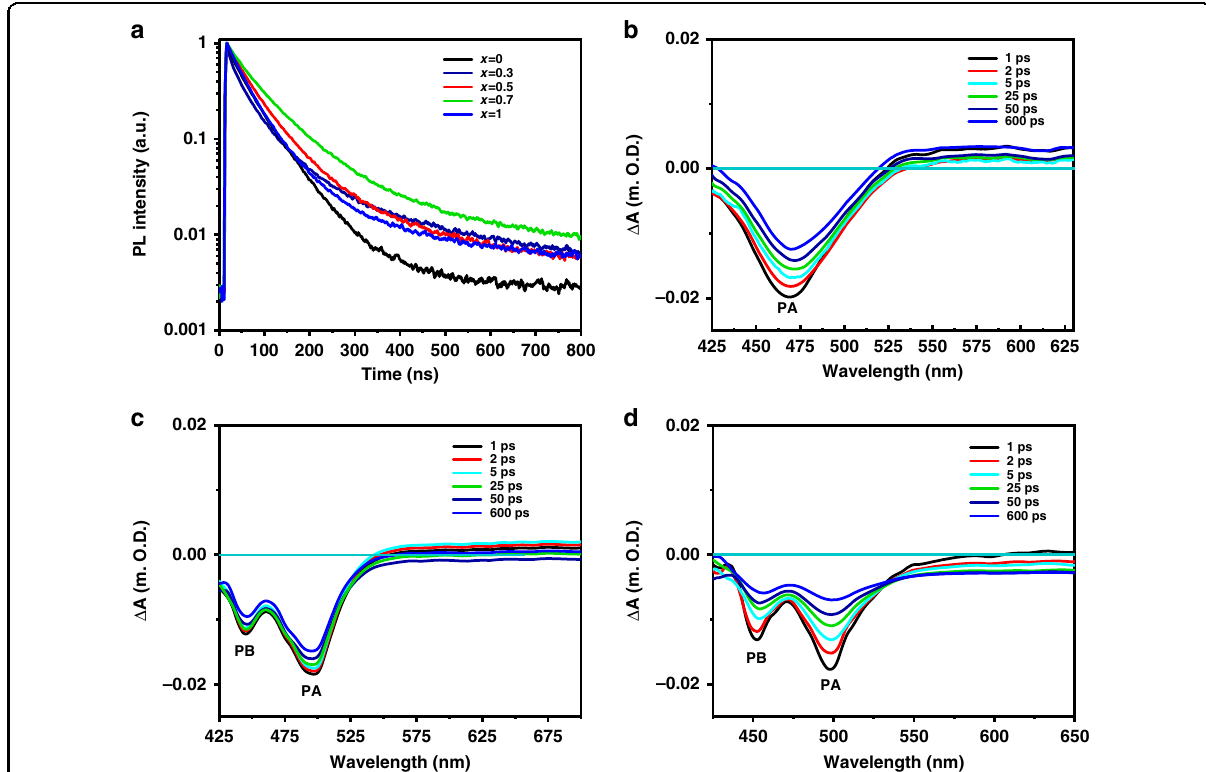
Fig. 3 Time-resolved PL spectra and transient absorption spectra. a PL decay curves of various InP/ZnSe x S 1 − x /ZnS QDs. b – d TA spectra of the InP/ZnSe x S 1 − x /ZnS QDs ( x = 0 ( b ), 0.7 ( c ), 1 ( d